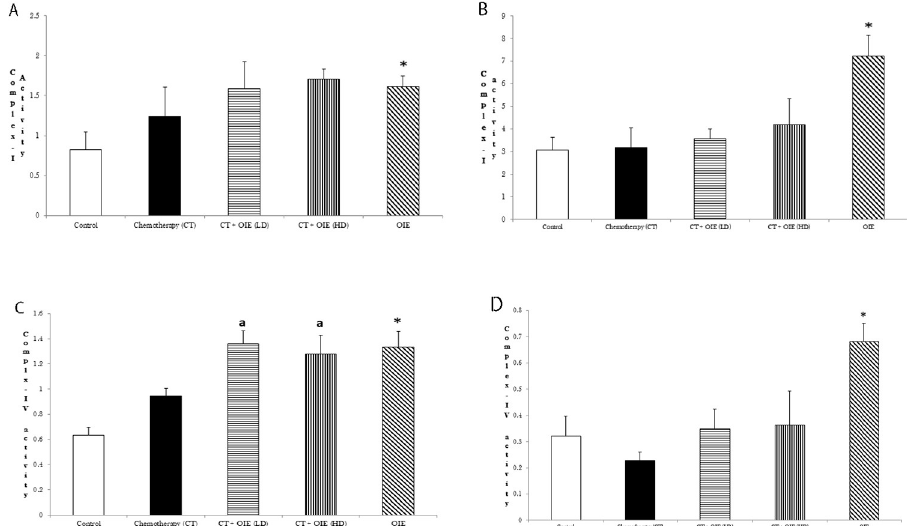
Fig 5. Effect of OIE on the mitochondrial function-Complex-I and Complex-IV activity. Complex-I activity was measured spectrophotometrically using NADH as substrate in the cortex (a) and the rest of the brain (b). Results are expressed as NADH oxidized ( μ M)/mg protein. Complex-IV activity was measured spectrophotometrically using cytochrome-C as substrate in the cortex (c) and the rest of the brain (d). Results are expressed as cytochrome-C